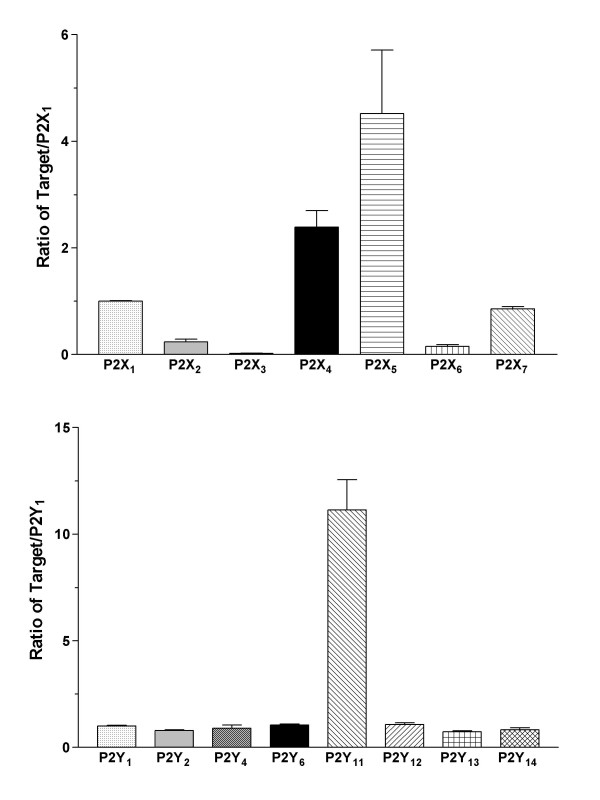
Relative expression of P2 receptors in LCLs. The relative expression of the P2X receptor gene (upper) and P2Y receptor gene (lower) in EBV-infected B cells (2 wks), LCLs, are presented (n = 4). The expression was normalized to GAPDH. P2X receptors were calibrated by P2X1 and P2Y receptors were calibrated by P2Y1. Data are the mean ± SEM.